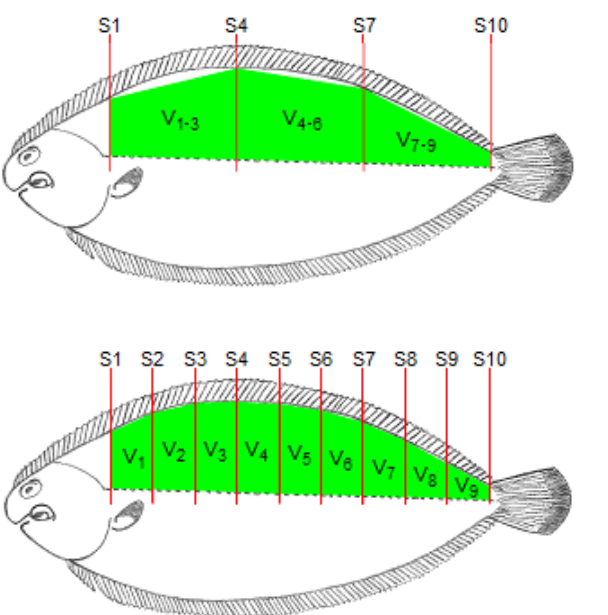
Figure 2. Schematic representation of the location of the cross-sectional RTU slices (S 1 , S 2 , S 3 , S 4 , S 5 , S 6 , S 7 , S 8 , S 9 and S 10 ).